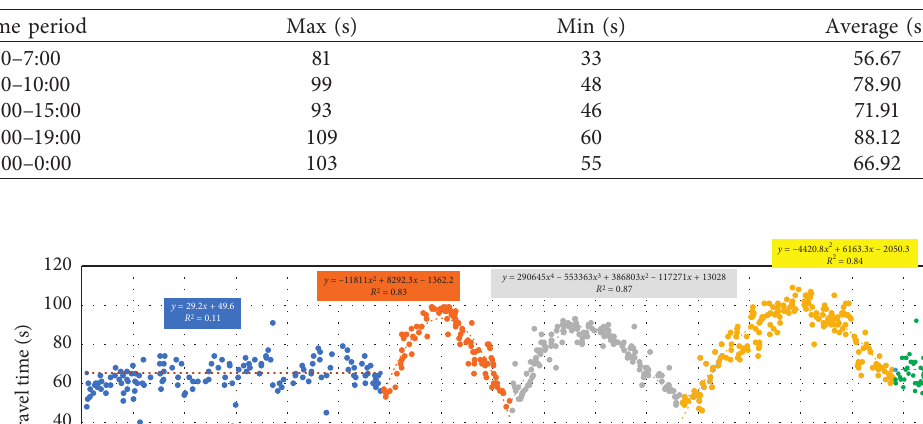
Table 3: Statistics of taxi travel times of Tieji Road during the five time periods.